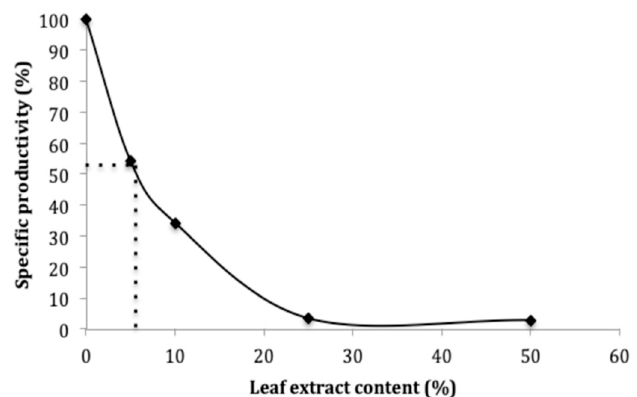
Figure 3. Inhibition of α -glucosidase through MLE. The IC50 values were graphically determined as the half-maximal inhibitory concentration of the inhibitor species giving 50% inhibition. All assays were performed in triplicate.